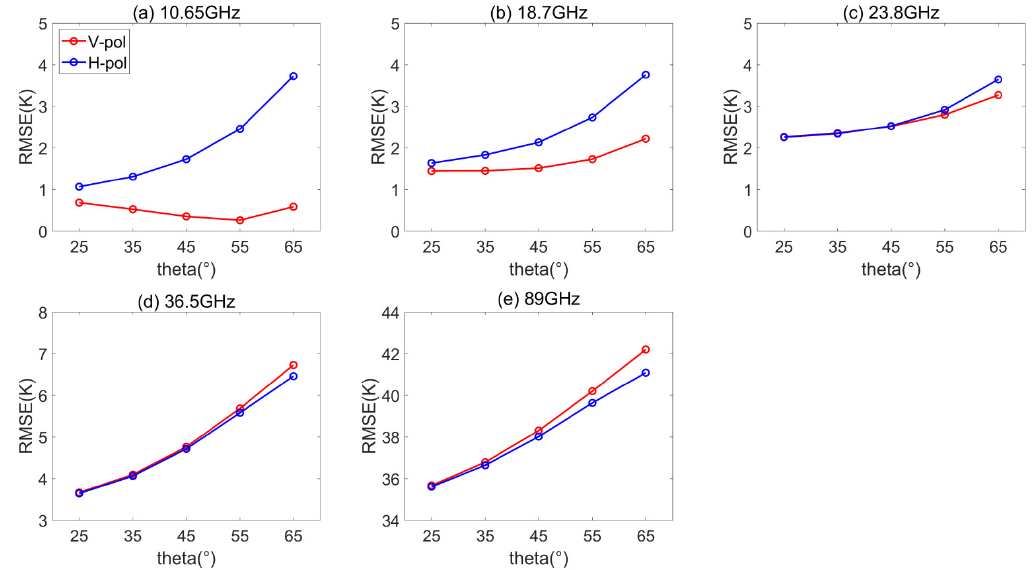
Figure 11. RMSE of simulated brightness temperature varies with theta at different bands. (Theta refers to incidence angle θ ).